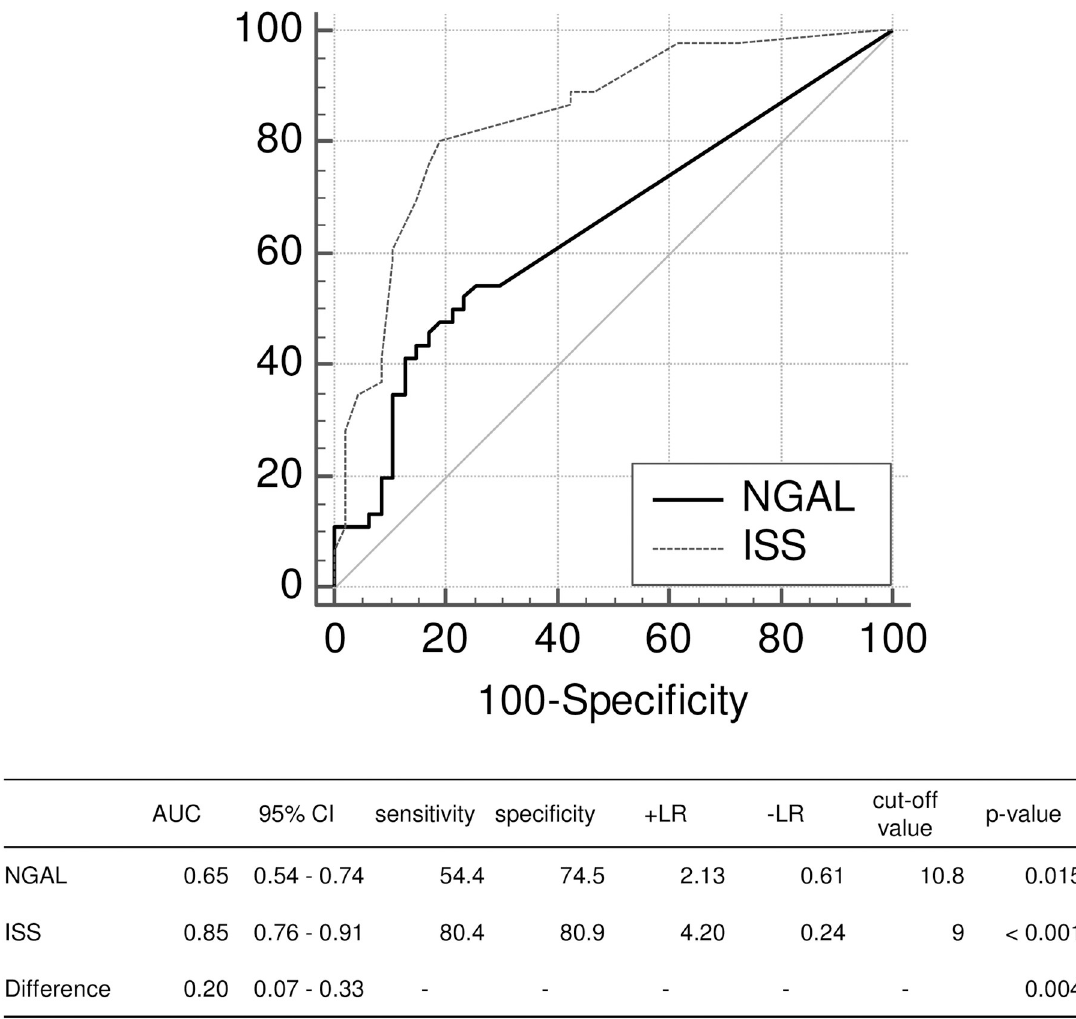
Fig 3. Comparison of the areas under the curve between NGAL levels and ISS on LOS. AUC: area under the curve; +LR: positive likelihood ratio; -LR: negative likelihood ratio; NGAL: neutrophil gelatinase-associated lipocalin; ISS: Injury Severity Score; LOS: length of hospital